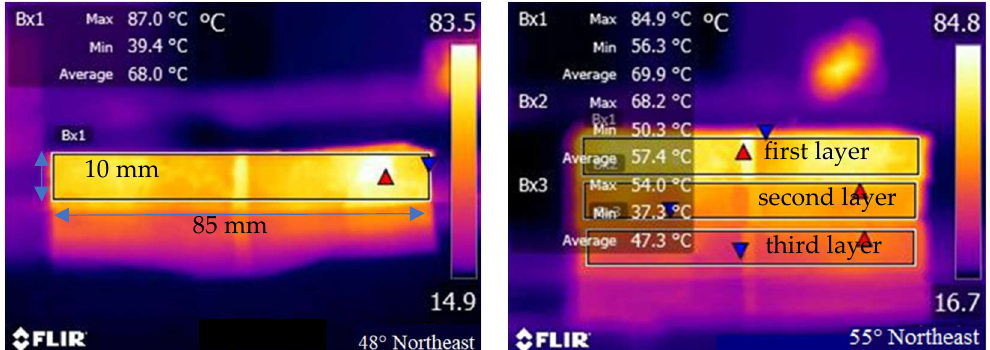
Figure 6. Infrared imaging of samples during induction heating. Materials 2018 , 11 , x FOR PEER REVIEW